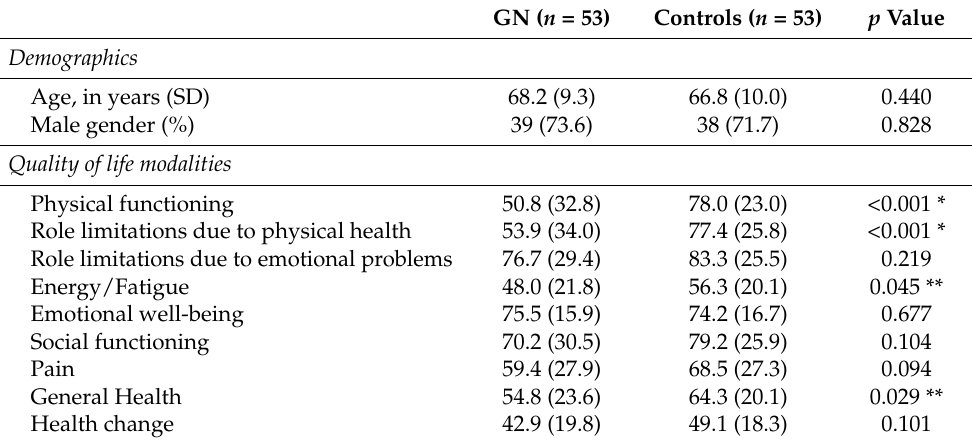
Table 1. Demopgraphics and quality of life (QoL) parameters of patients with gluten neuropathy (GN).